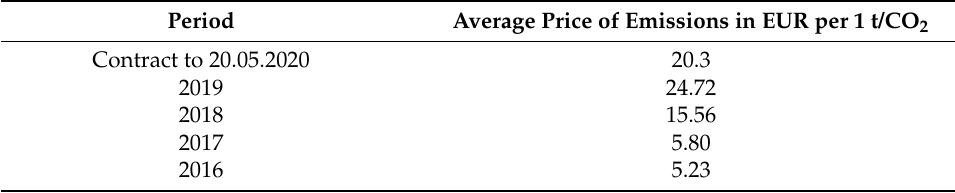
Table 2. Development emission allowances price per 1 tonne of CO 2